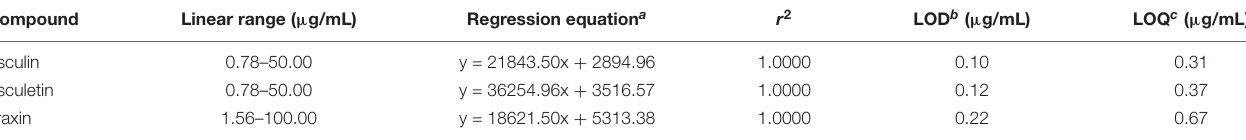
FIGURE 2 | FX extract standardization via HPLC analysis . (A) Three-dimensional HPLC chromatogram of the FX sample. (B) Retention times and contents (mg/g) of EC, ECT, and FR. TABLE 2 | Linear range, regression equations, r 2 , LODs, and LOQs of the eight bioactive compounds. Compound Linear range ( µ g/mL) Regression equation a r 2 LOD b ( µ g/mL) LOQ c ( µ